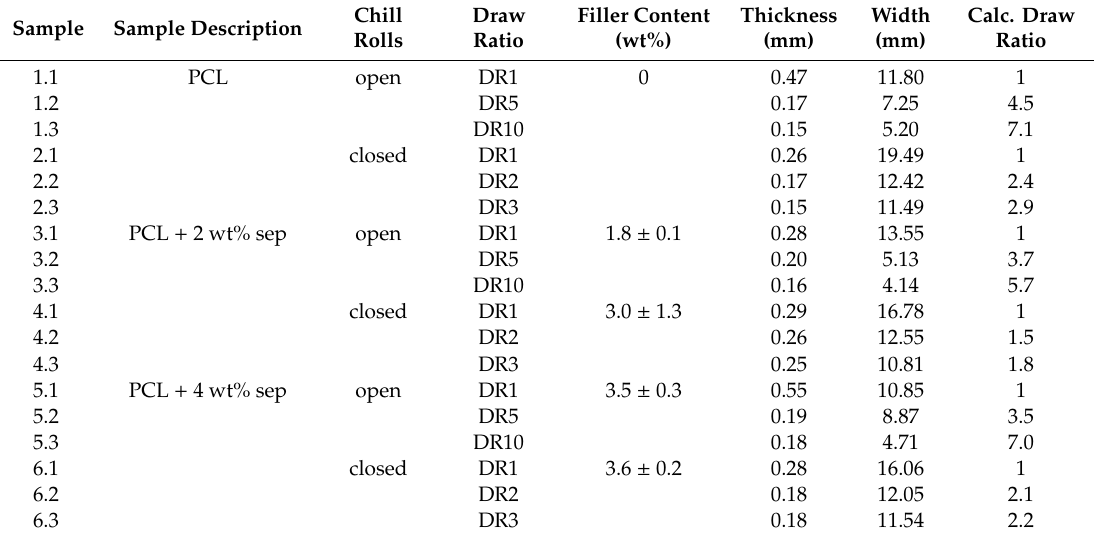
Table 3. Overview of dimensions, the calculated draw ratios, and the filler content (average ± standard deviation) for the di ff erent samples employed in this study.